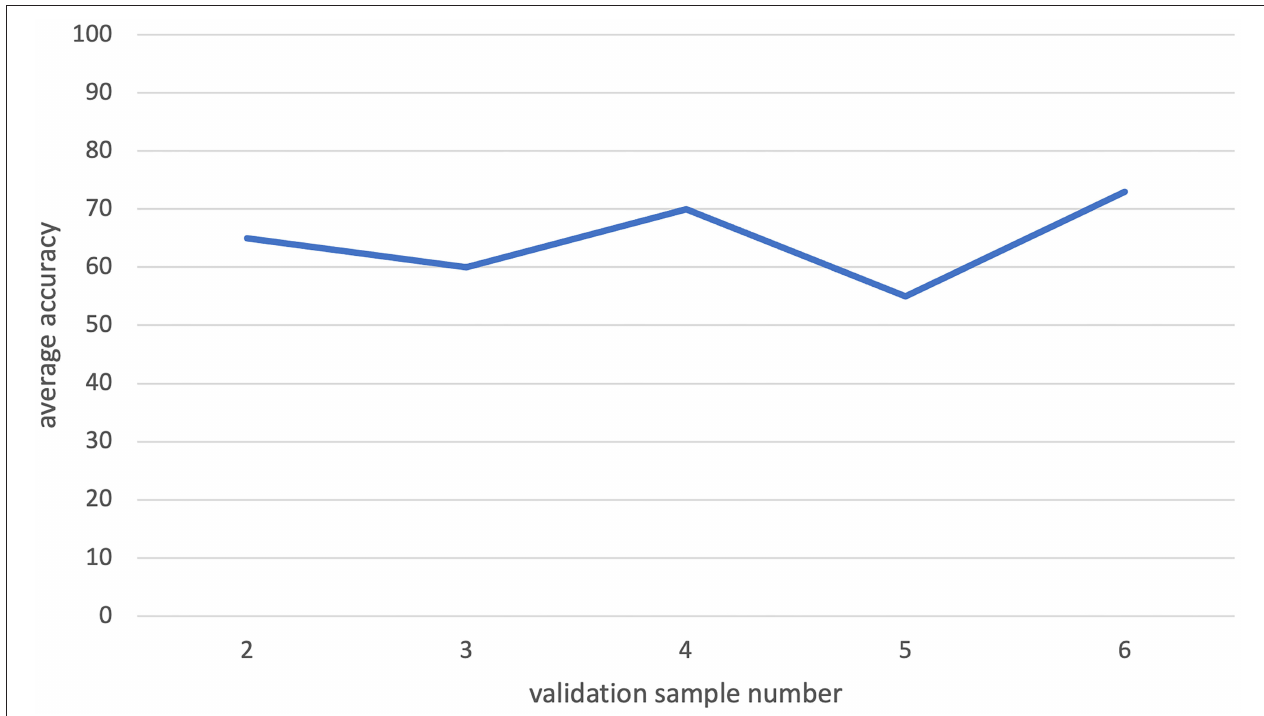
FIGURE 8 | The leave-one-out classification result for increasing validation dataset sizes while training size is fixed. There is no visible increasing pattern in the graph. So, increasing validation size does not have a significant effect on the classification